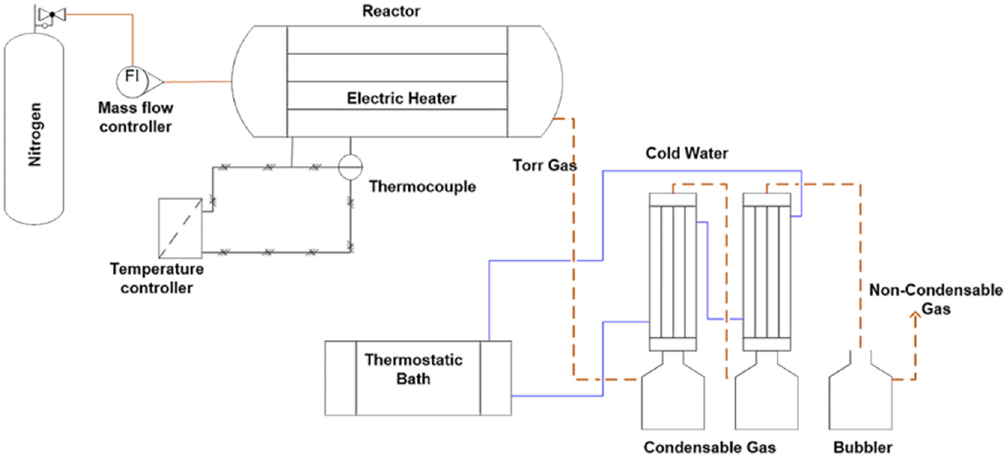
Figure 1. Bench-scale torrefaction apparatus.